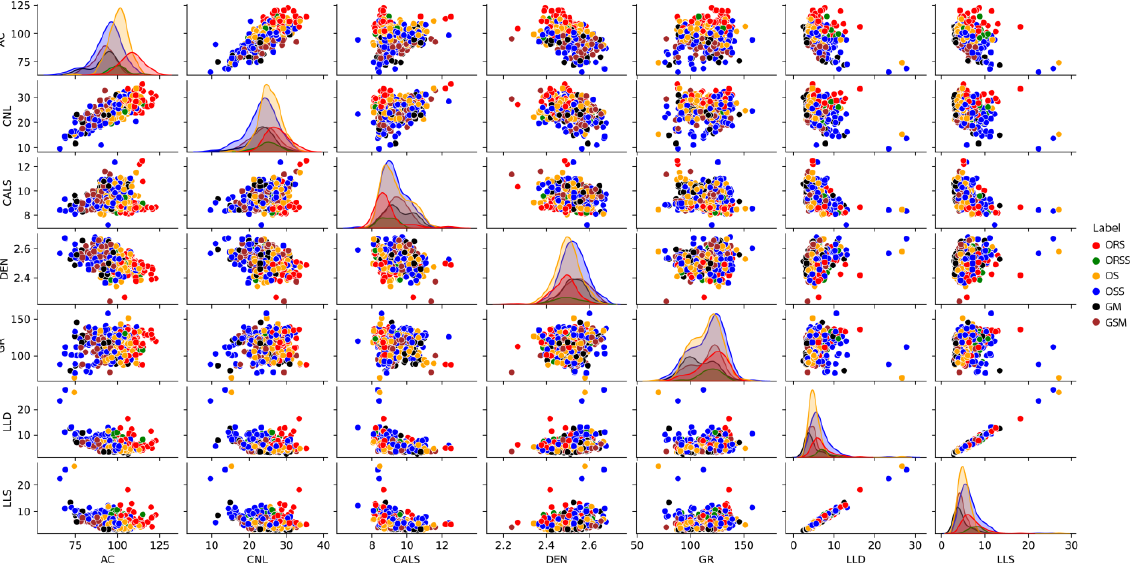
Figure 5. Cross plots of seven well logs, with six lithofacies represented by different colors. Six lithofacies are identified in the Gulong Shale, including organic-rich shale (ORS), organic-rich siliceous shale (ORSS), organic shale (OS), organic siliceous shale (OSS), gray mudstone (GM), and gray siliceous mudstone (GSM). Refer to the text for abbreviations of well logs.